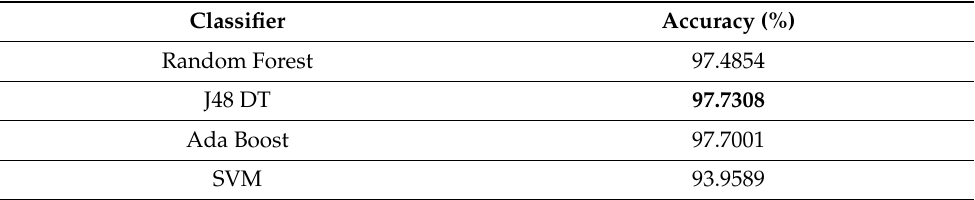
Table 11. Comparative results for the classifiers.